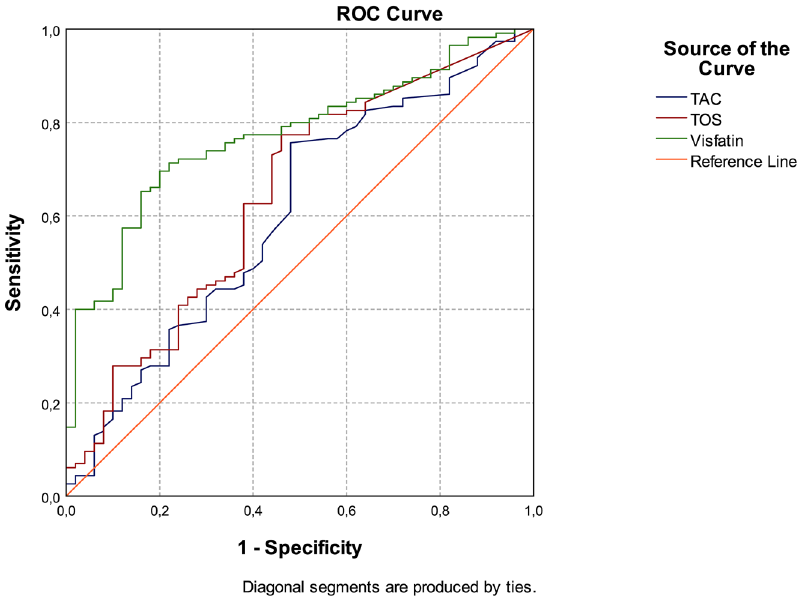
Figure 1: The ROC curve for TAC, TOS, and visfatin in patients with dental caries and caries-free